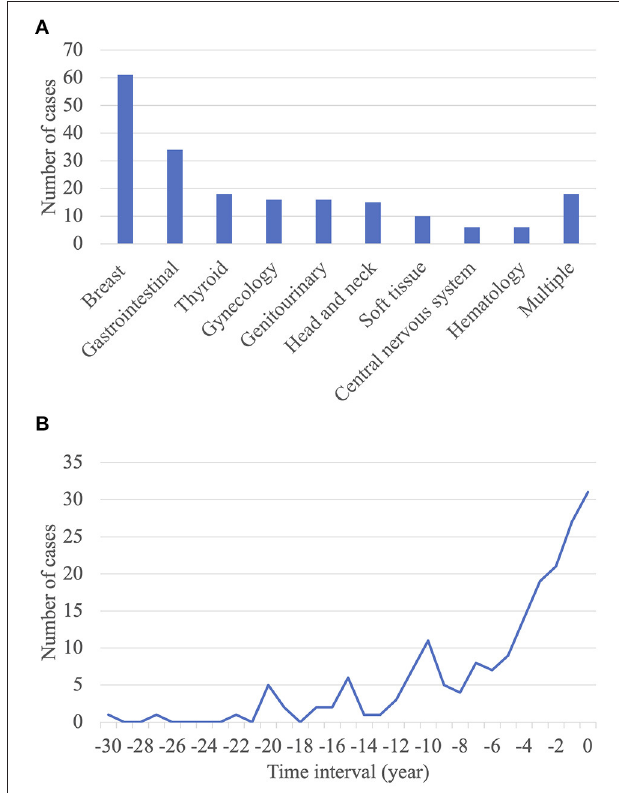
FIGURE 2 | Characteristics of extrapulmonary malignancies. (A) Distribution of occurrence sites of previous extrapulmonary malignancies. (B) Time interval between the diagnosis of previous extrapulmonary malignancies and that of primary lung